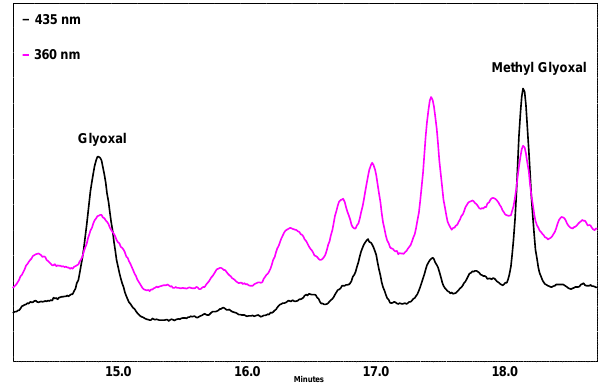
Figure 3. Example of sample chromatogram from Chatham Rise, using absorption at 360nm (pink line) and 435nm (black line).